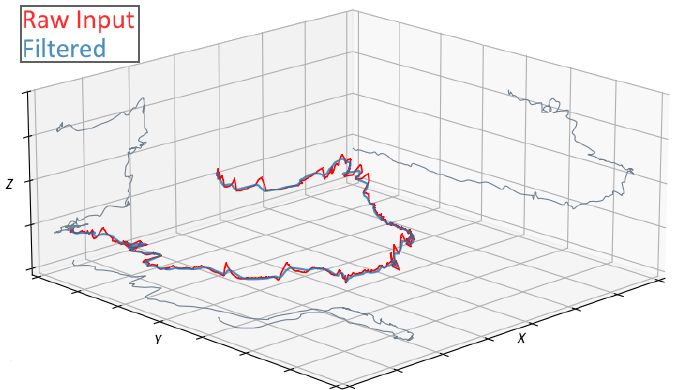
Figure 10. Localization experiment. Location is tracked along a corridor and up a staircase to the floor above. The red line represents the UWB raw input, and the blue is the value received after the Kalman filter has been applied. The projections of the measurement at three planes are displayed for perspective.